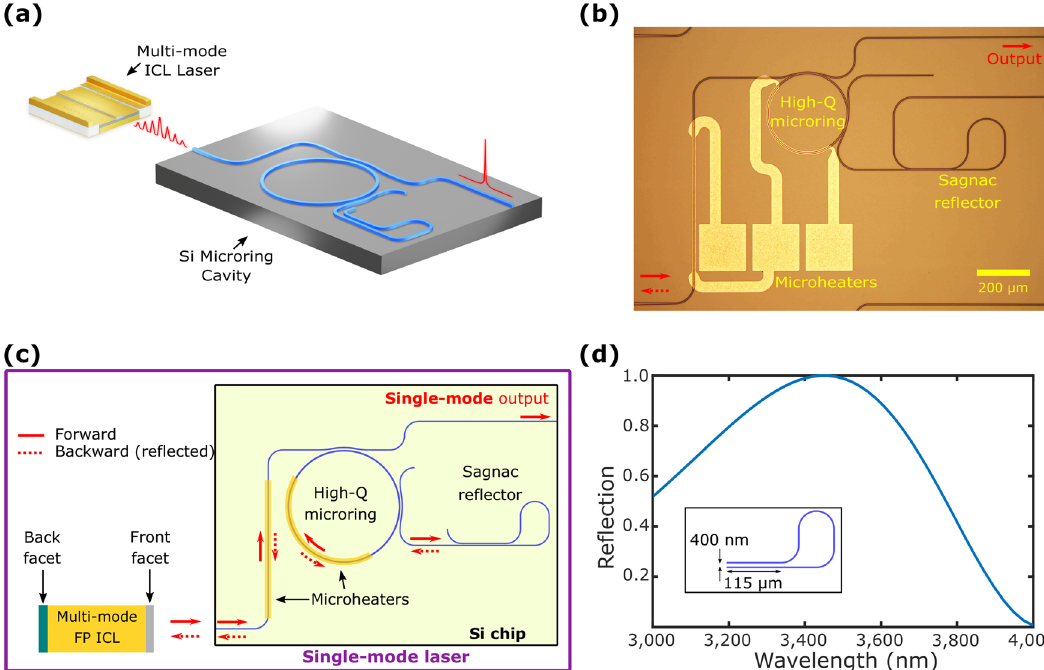
Fig. 1 Single-mode laser platform by integrating a multi-mode Fabry – Perot (FP) interband cascade laser (ICL) laser with a high quality factor ( Q ) microresonator. a Illustration of a single-frequency mid-IR source, consisting of a multi- mode ICL laser and a silicon microring cavity. b Microscope image of the silicon chip with a 150- μ m radius high- Q microring (coupling gap of 510 nm), a Sagnac re fl ector, and aluminum microheaters. c Schematic of the single-mode laser. A multi-mode ICL around 3.4 μ m with an anti-re fl ection coating on the front facet. The Sagnac re fl ector at the drop port provides frequency-selective optical feedback and form an external cavity with the ICL back facet. Microheaters are placed on top of the bus waveguide and the microring to control the phase of the external cavity and the ring resonance, respectively. d Simulated re fl ection spectrum of the Sagnac loop mirror over wavelengths from 3 μ m to 4 μ m using Finite-Difference Eigenmode solver. The Sagnac loop mirror re fl ects about 99% at the drop port at 3.4 μ m. A coupler of the Sagnac loop mirror at the drop port consists of a 400nm gap and a 115 μ m length.